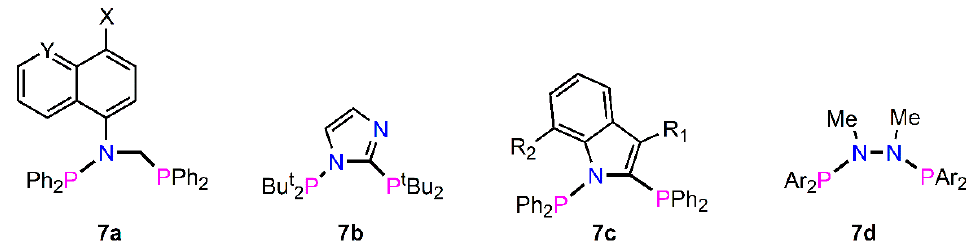
Figure 10. Selected examples of P–C–N–P diphosphines.